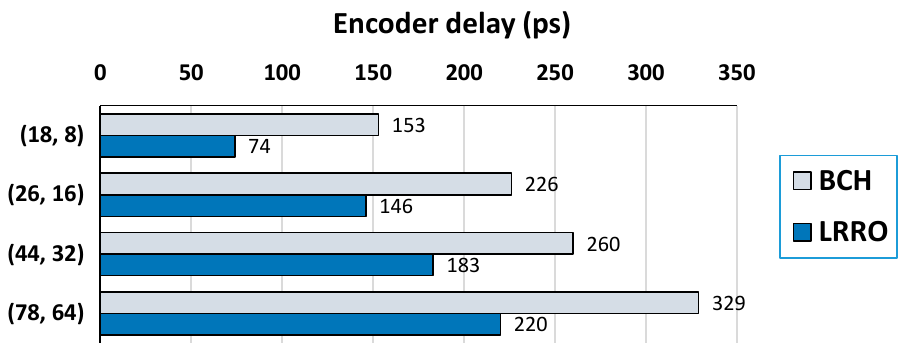
Figure 7. Propagation delay of the encoder circuits (in ps).